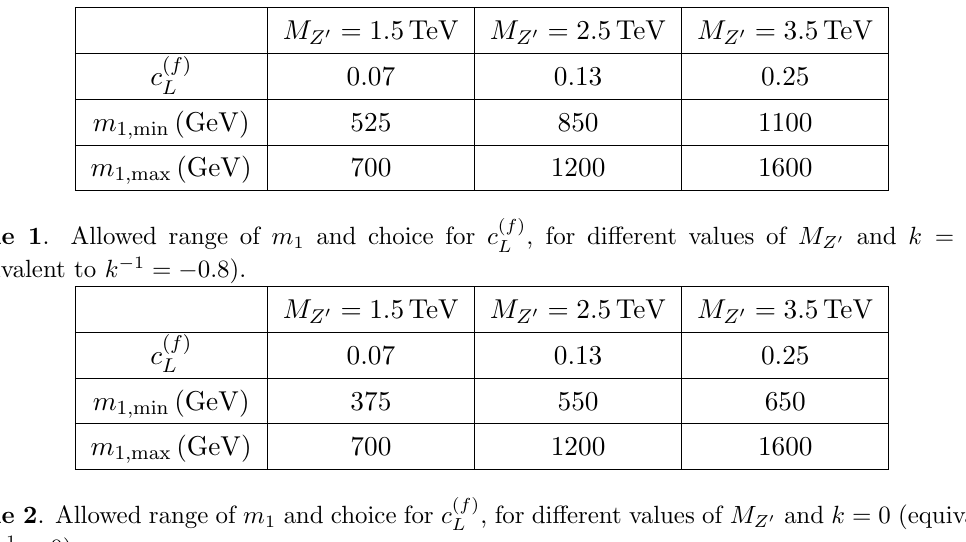
Table 2 . Allowed range of m to k (cid:0) 1 =